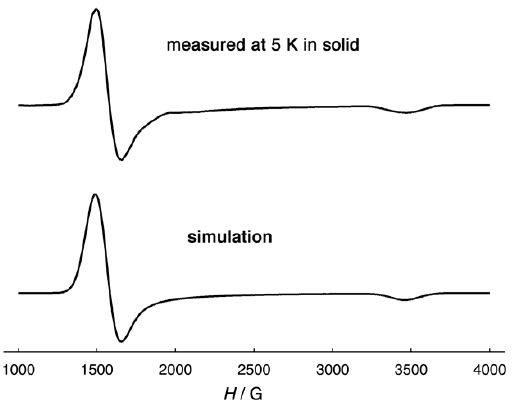
Figure 8. EPR spectra of 2 . The simulated spectrum was drawn with the parameter values of g z = 1.980, g x = g y = 4.385, W z = 120 G, and W x = W y = 85 G.